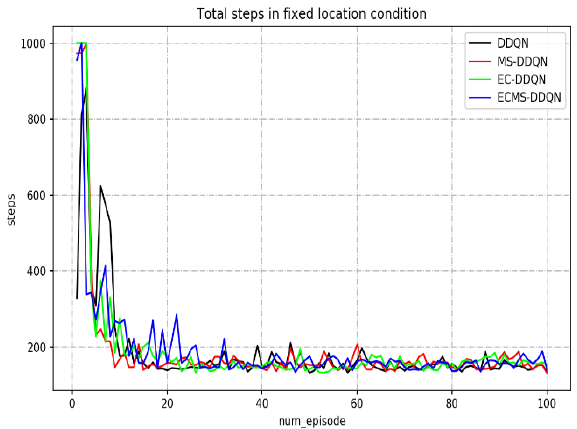
Figure 4. The number of steps consumed by the four algorithms in a fixed location scene.